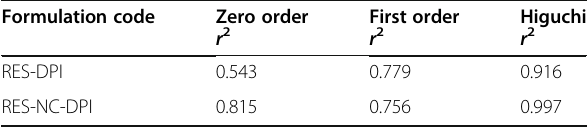
Table 3 In vitro release kinetics in the cellophane membrane of RES-DPI and RES-NC-DPI Formulation